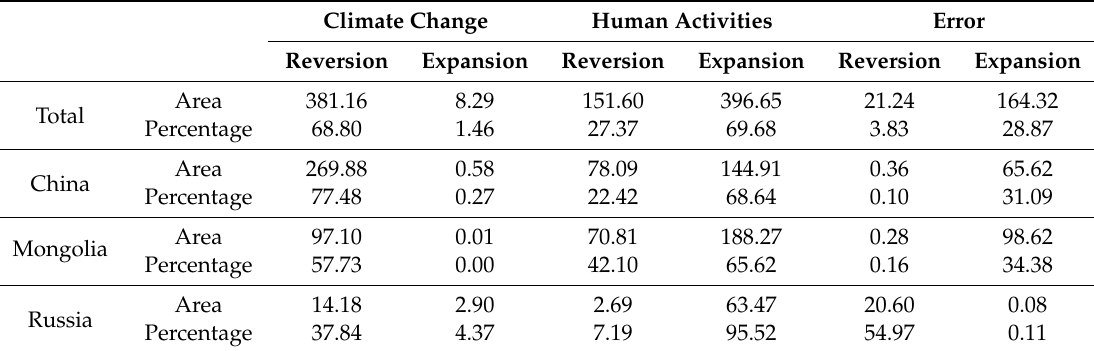
Figure 7. The spatial differences between human activities and climate change on desertification reversion ( a ) and expansion ( b ). Table 9. The di ff erences in desertification change caused by climate change and human activities (area: km 2 ; percentage: